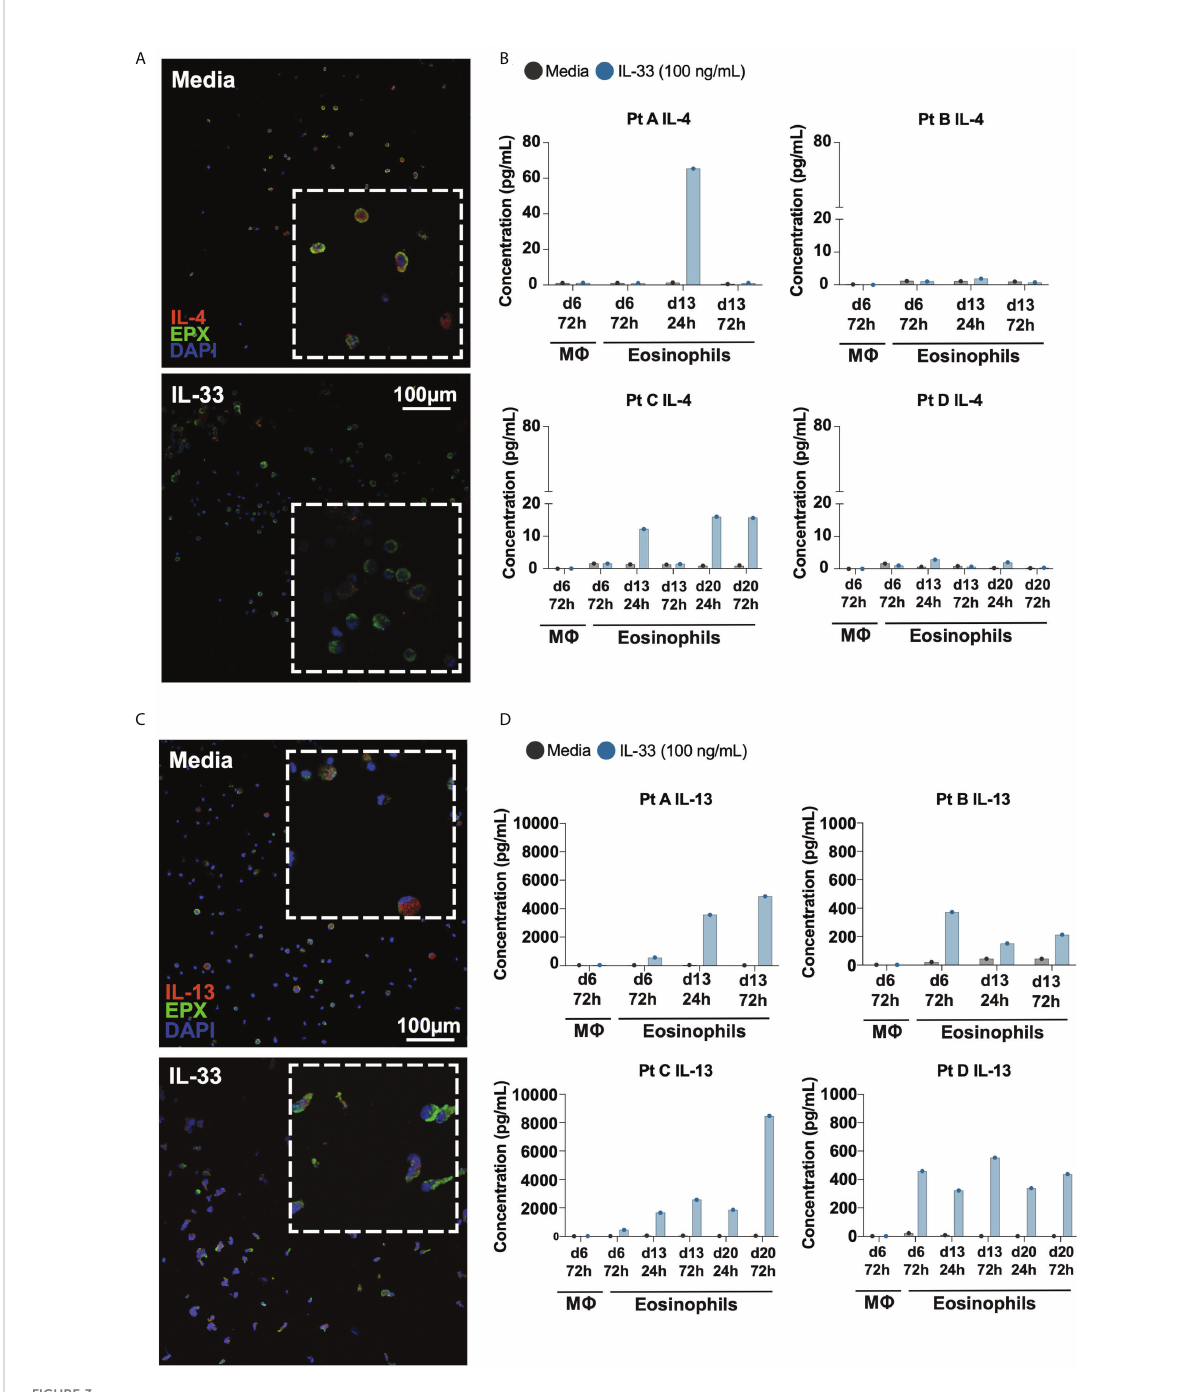
FIGURE 3 Differentiated eosinophils release IL-4 and IL-13 protein in response to IL-33. Immuno fl uorescence staining of differentiating eosinophils on d14 for (A) IL-4 and (C) IL-13. Cytokine analysis of supernatants of media and IL-33 treated cells at various time points detects (B) IL-4 and (D) IL-13 concentrations for each individual